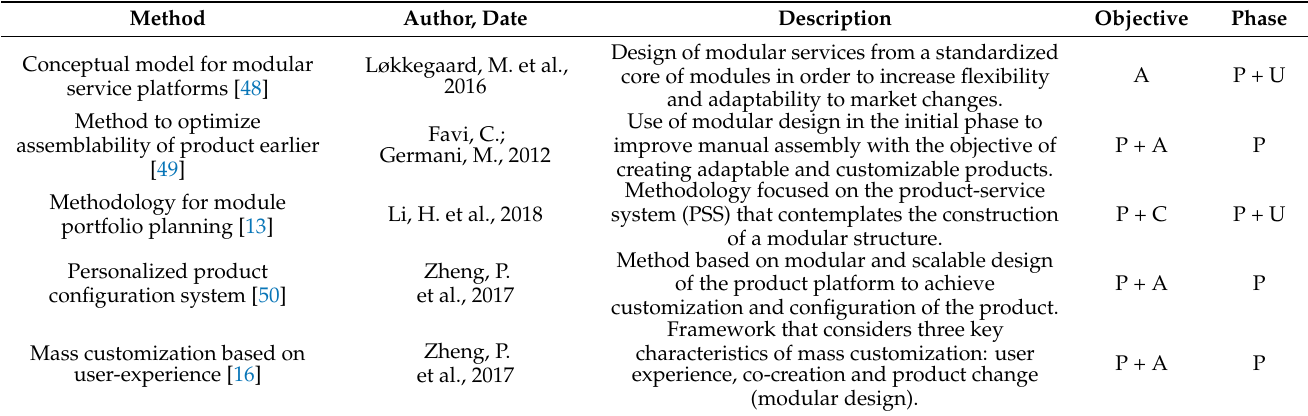
Table 2. User-focused modular design